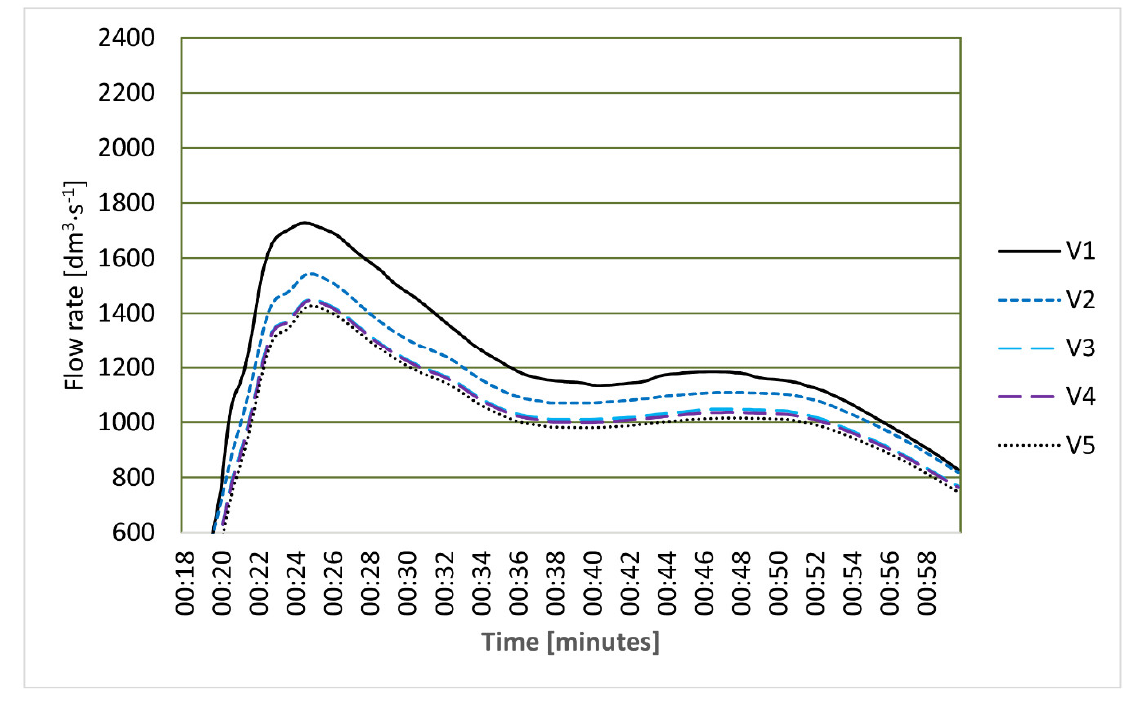
Figure 10. Change in flow rate in Link-30 canal—F = 2 years.